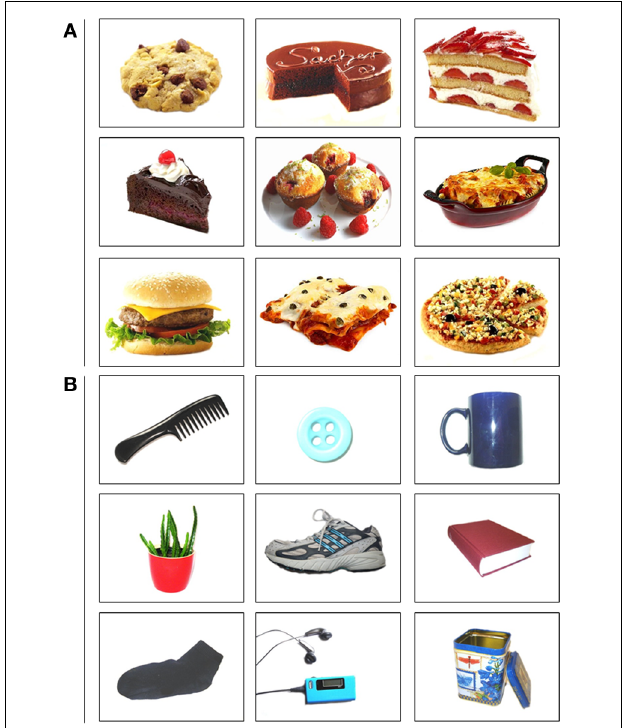
FIGURE 1 | Stimulus set of (A) food pictures and (B) neutral pictures in study 1.